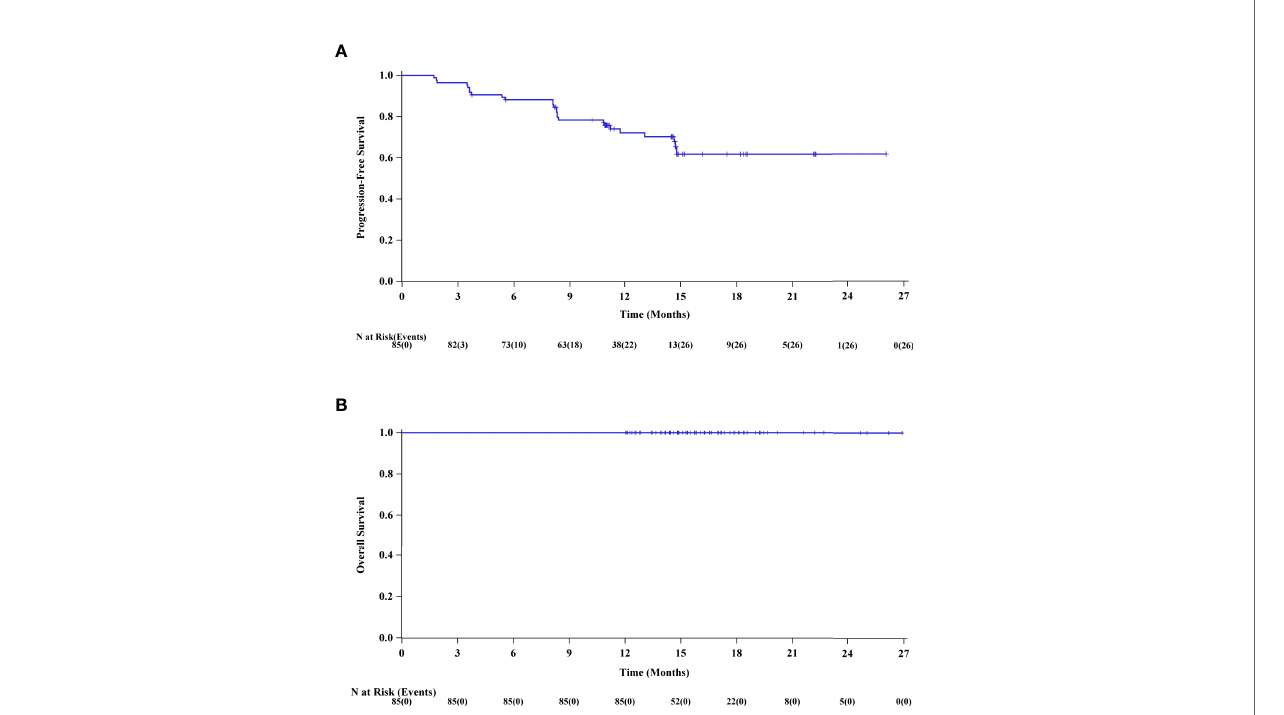
FIGURE 2 | (A) The Kaplan-Meier curve of progression-free survival (PFS) of the FAS. (B) The Kaplan-Meier curve of overall survival (OS) of the FAS.